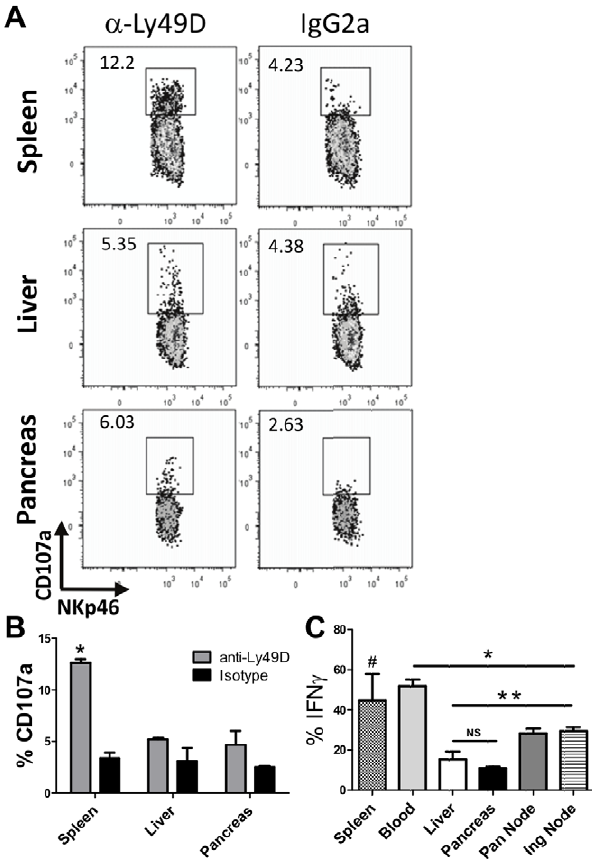
Figure 4. Exvivo cytolytic potential and cytokine secretion are lower in pancreatic and liver NK cells. A) NK cells pooled from five 8-week-old NOD mice were stimulated for four hours with plate-bound anti-Ly49D in the presence of an antibody to CD107a to mark cytolytic granule release. B) Summary of results from 3 experiments. * p , 0.05 versus all other groups (unpaired T test). C) NK cells pooled from 8- week-old NOD mice were stimulated with IL-12 + IL-18 in the presence brefeldin A for four hours and then stained for intracellular IFN c . Results are pooled from 4 independent experiments. * The frequency of NK cells producing IFN c in blood was significantly higher than NK cells in pancreatic (Pan) or inguinal (Ing) lymph nodes ( p , 0.005) and in the liver and pancreas ( p , 0.0001), **% of NK cells expressing IFN c in both nodes was higher than in the pancreas ( p , 0.001), # % of NK cells expressing IFN c in the spleen was significantly higher than in pancreas ( p =0.04). NS, there was not a significant difference between the percentage of NK cells expressing IFN c in the liver and pancreas according to an unpaired T test.